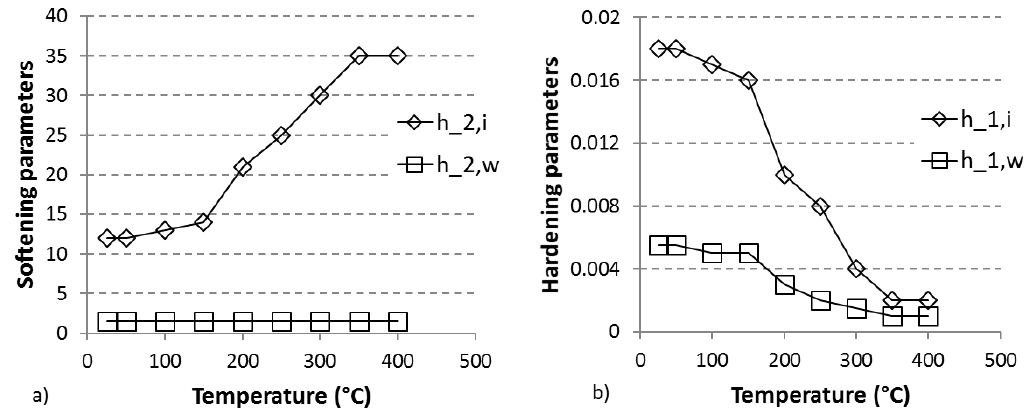
Figure 12. Softening ( a ) and hardening ( b ) parameters as a function of the temperature for dislocation